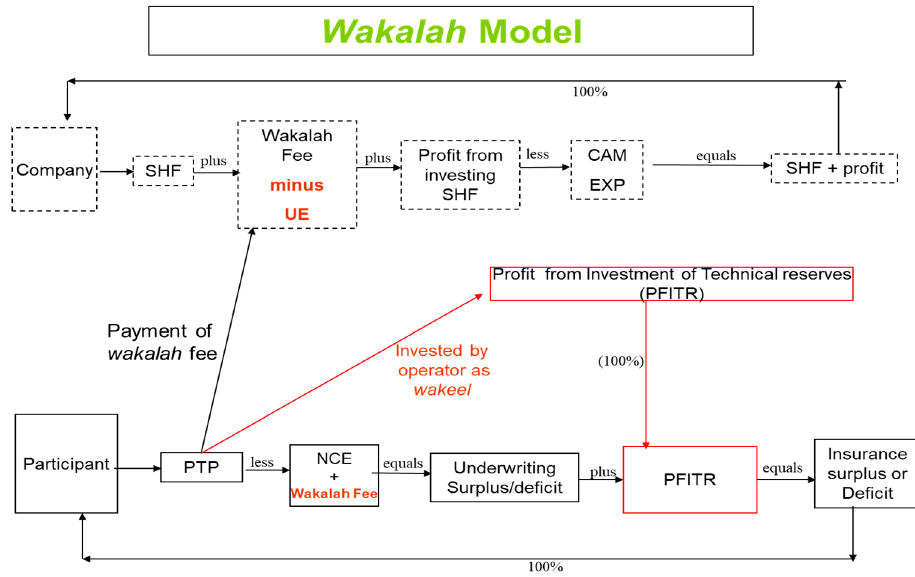
Figure 2. Wakalah- based operational model of takaful.